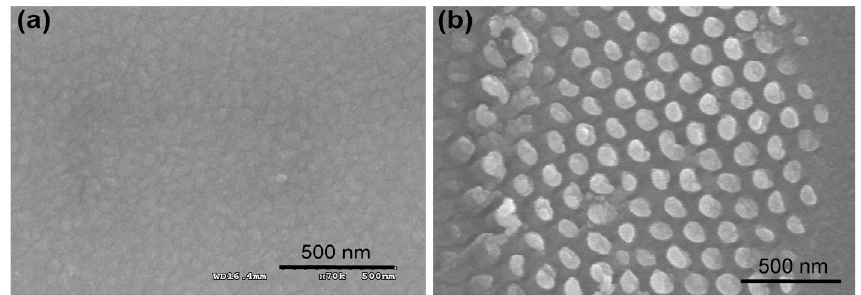
Figure 1. Schematic representation of redox phenomena at cell-substrate interface ( i ) and the redox peaks obtained from PC12 cell immobilized on peptide fabricated Au electrode ( ii ); ( iii ) cyclic voltammetry (CV) for comparing the electrochemical signal using C(RGD) 4 , Arginine-Glycine-Aspartic acid-Multi Armed Peptide terminated with Cysteine (RGD- MAP-C) and poly- L -lysine (PLL) fabricated Au electrode without PC12 cell. Reproduced with permission from [28], Copyright 2010,